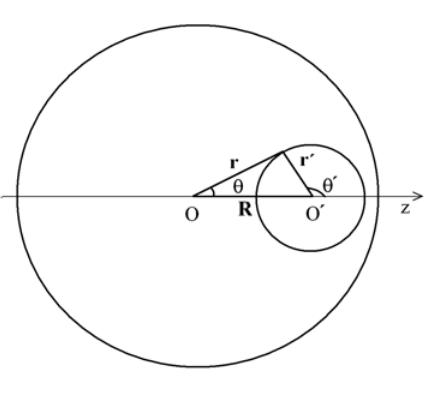
Fig. 1. A sketch of a skyrmion located inside a finite nucleus with R = R the separation between the geometrical center (O’) of the | | skyrmion and the center (O) of the nucleus. The vectors (angles) r ( θ ) and r ′ ( θ ′ ) refer to the body-fixed coordinates of the nucleus and skyrmion, respectively. Since the nucleus is spherically sym- metric, both coordinate systems can be orientated in such a way that their z -axes